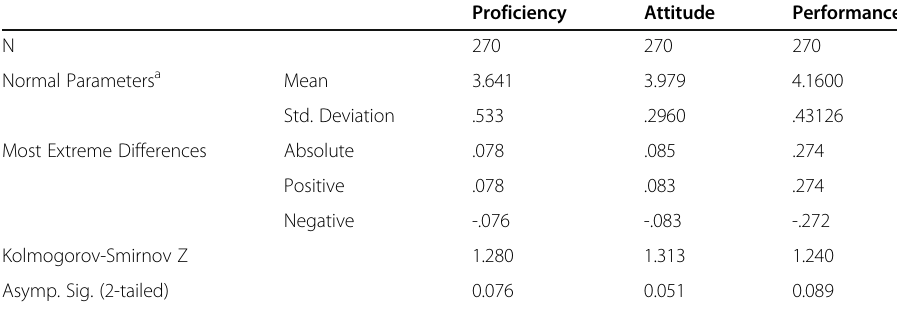
Table 4 The output of the Kolmogorov-Smirnov test to verify the normality of the performance, proficiency, and attitude